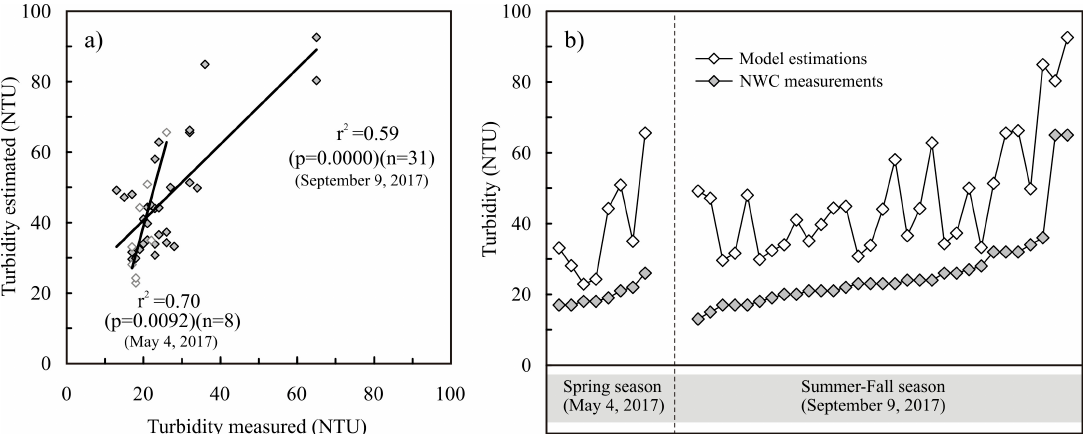
Figure 11. ( a ) Turbidity-prediction empirical models; ( b ) absolute model deviations.